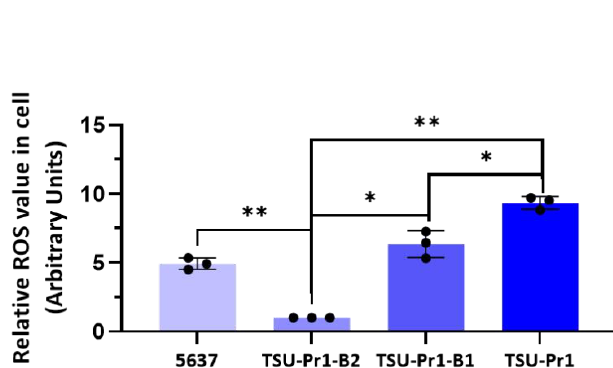
Figure 7. ROS level of PAM-treated 3D bladder cancer cell spheroids. ( a ) Representative images of ROS staining. After 6 days of 50% 10PAM treatment, the four cell line spheroids were stained for ROS and images were taken. DNA was assessed with Hoechst 33342 in blue and ROS staining with CellROX in yellow. The use of both of these stains in conjunction with the confocal capability of the InCell 6500HS instrumentation shows that the ROS staining is at the edge/surface, either surrounding the cell mass reflected by DNA staining (as in TSU-Pr1-B2) or above or below as in the other cell lines depicted. Scale = 100 µm. ( b ) The quantification of ROS level. Average of 3 technical replicates normalized to TSU-Pr1-B2 ROS luminescence. N = 1. These results are from a single pilot experiment with 10 spheroids for each treatment group . “*” represents a p < 0.05 and “**” represents a p < 0.01.